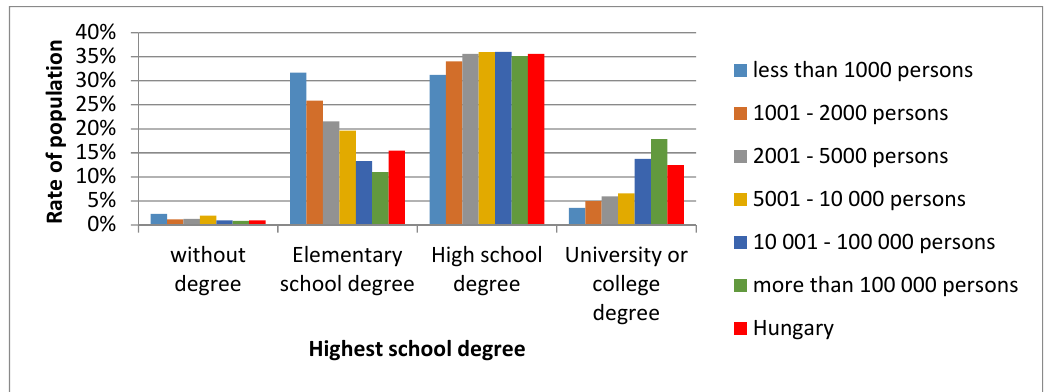
Figure 5. The highest completed level of education among persons aged over seven years old; breakdown by population categories (percentage ‐ wise) (authors’ edition based on KSH database).